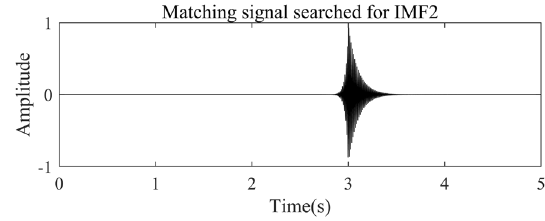
Figure 12 Signals constructed by parameters after